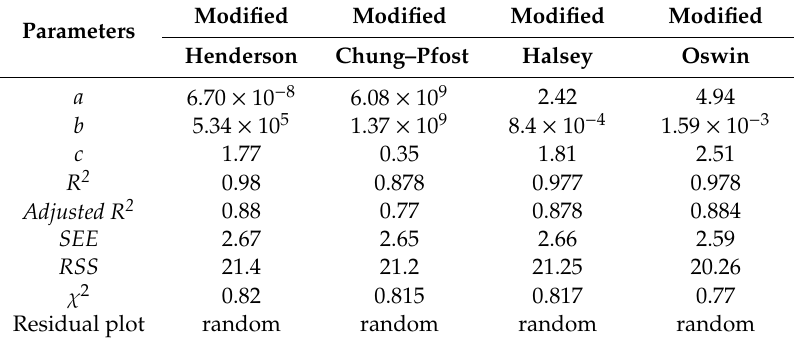
Table 4. Model coe ffi cients and statistical results for whole palm kernel.